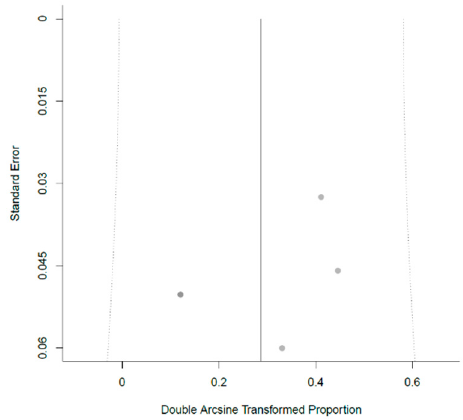
Figure 2. Funnel plot for the meta-analysis.